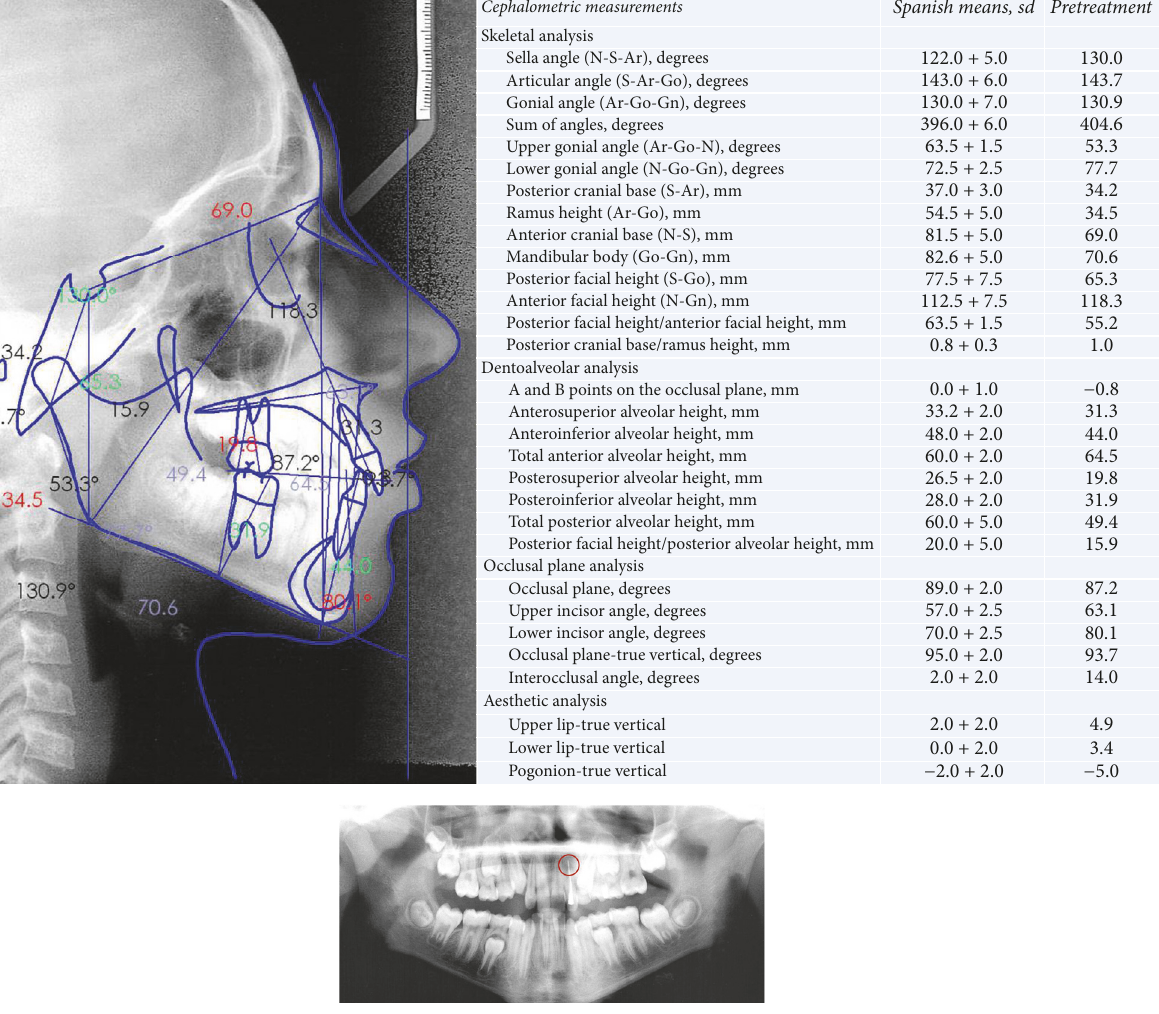
Figure 2: Panoramic radiograph, lateral radiographic records, and cephalometric